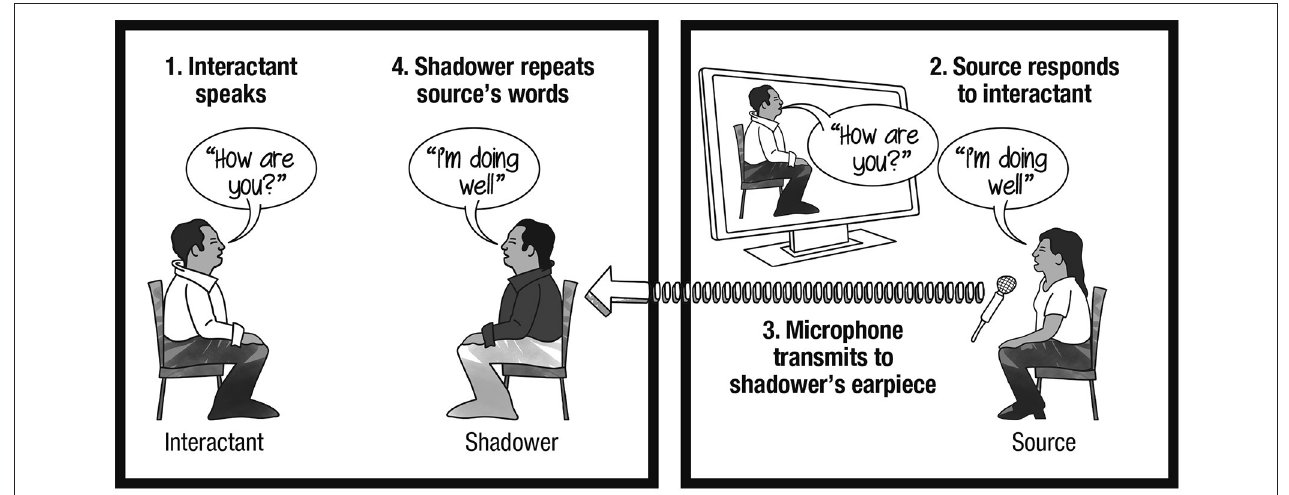
FIGURE 1 | Combining a speech source and a speech shadower to produce a cyranoid.